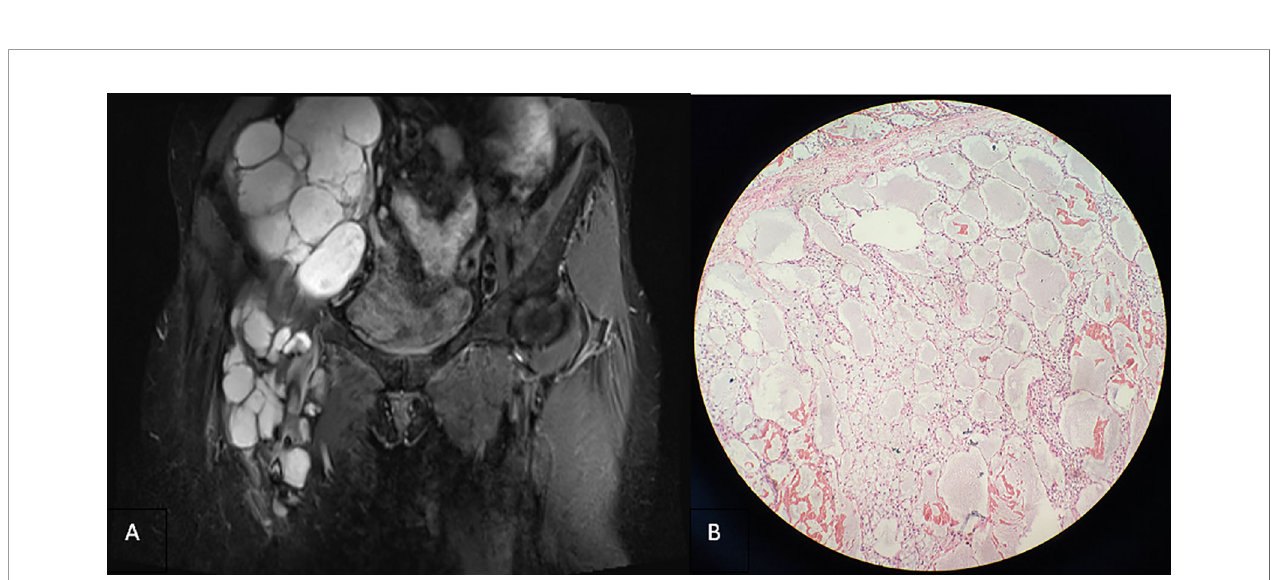
FIGURE 3 | (A) Coronal T2-weighted imaging lipid pressure sequence (2015) revealing multiple cystic lesions of varying sizes in the right inguinal region, in fi ltrating and growing along the tissue space behind the peritoneum and the space between the anterior femoris muscle group, with uneven signal intensity, scattered spots and slightly low signal intensity, and less uniform thickness of the septum. (B) Microscopically, multiple cystic dilated lymphatic vessels of different sizes, partial hyperplasia, endothelial cell proliferation and accumulation, atypical nucleus, thick nuclear membrane, and polar disappearance of nucleus and nucleolus are observed in some cells (hematoxylin and eosin stain,